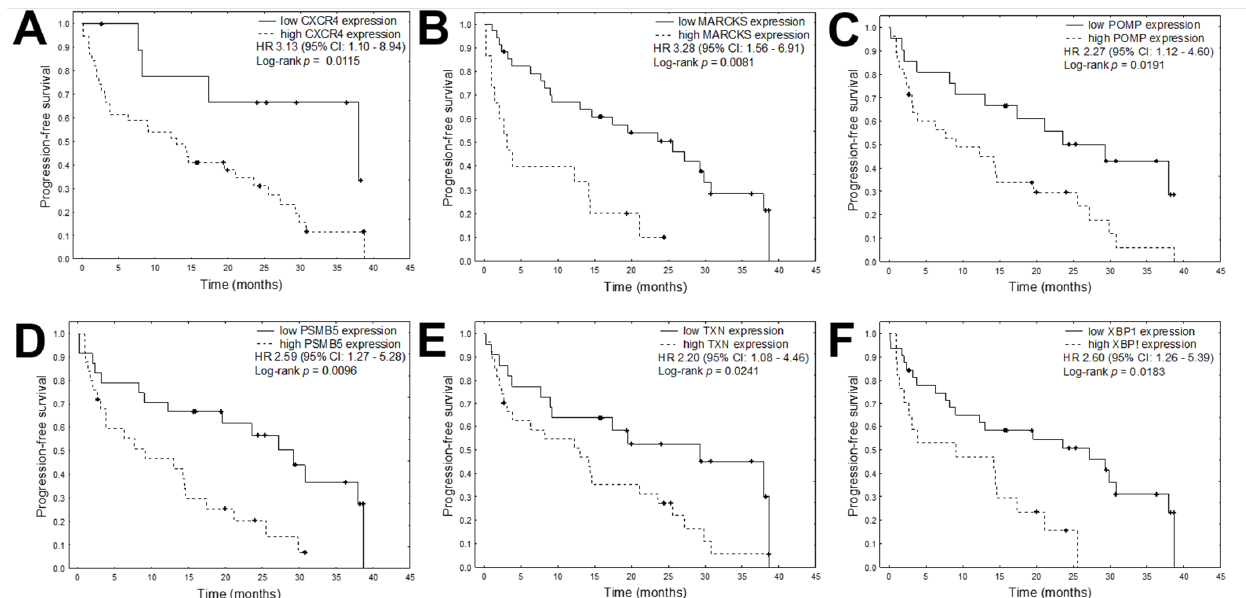
Figure 3. Kaplan–Meier plots for each of the significant mRNAs in the univariate analyses for PFS: ( A ) CXCR4 , ( B ) MARCKS , ( C ) POMP , ( D ) PSMB5 , ( E ) TXN , ( F ) XBP1 .